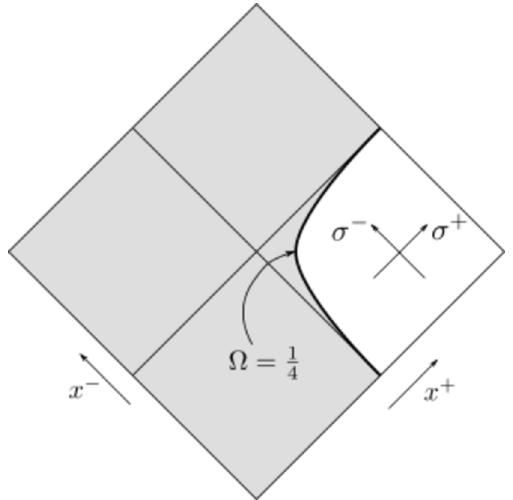
Figure 1 . Linear dilaton vacuum. The physical spacetime is the unshaded region, with a boundary at (cid:10) = 1 4